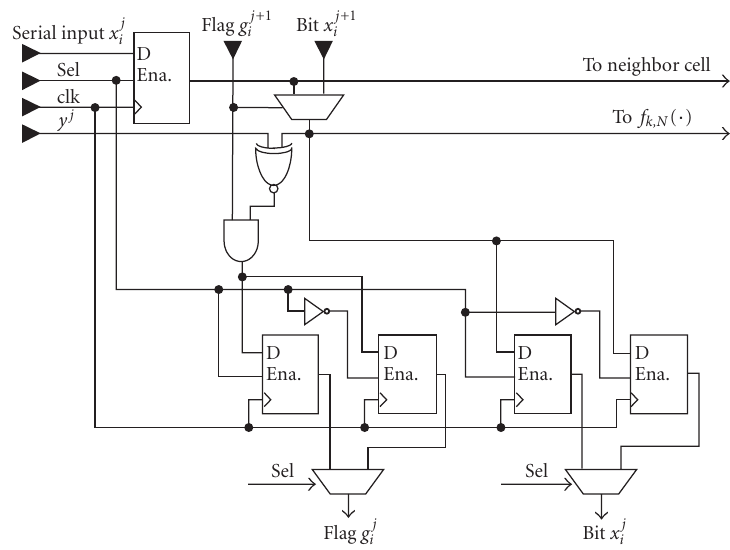
Figure 10: Double-propagation-cell internal structure.